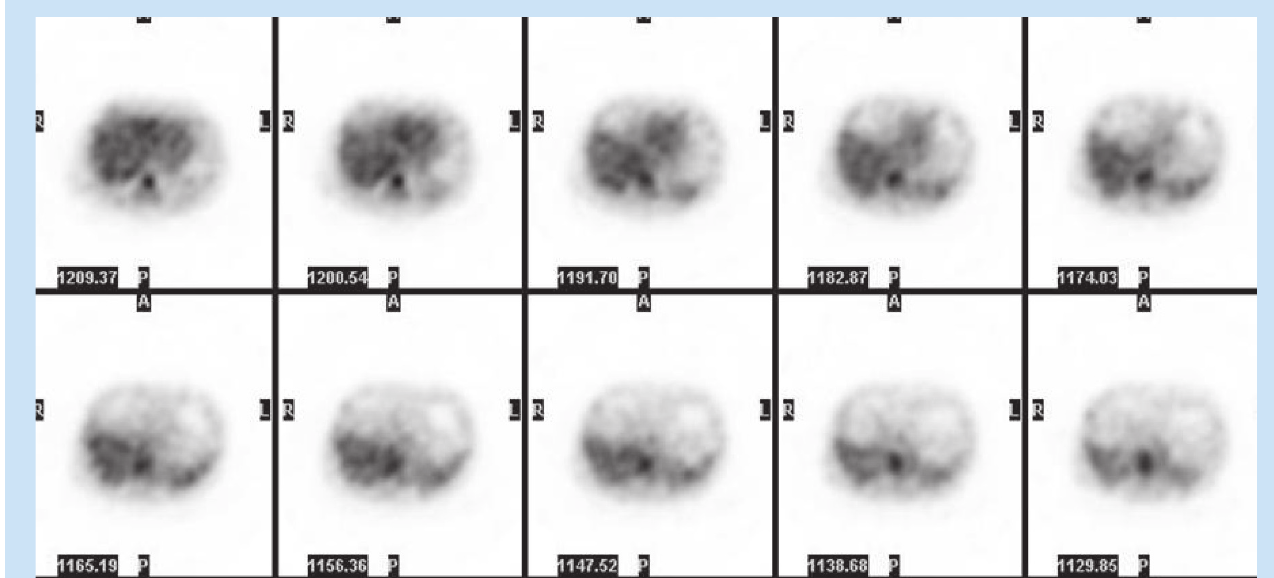
Fig. 1. SPECT-reconstructed images of the gallium-67 scans showing a ‘cold’ area on the transverse plane.